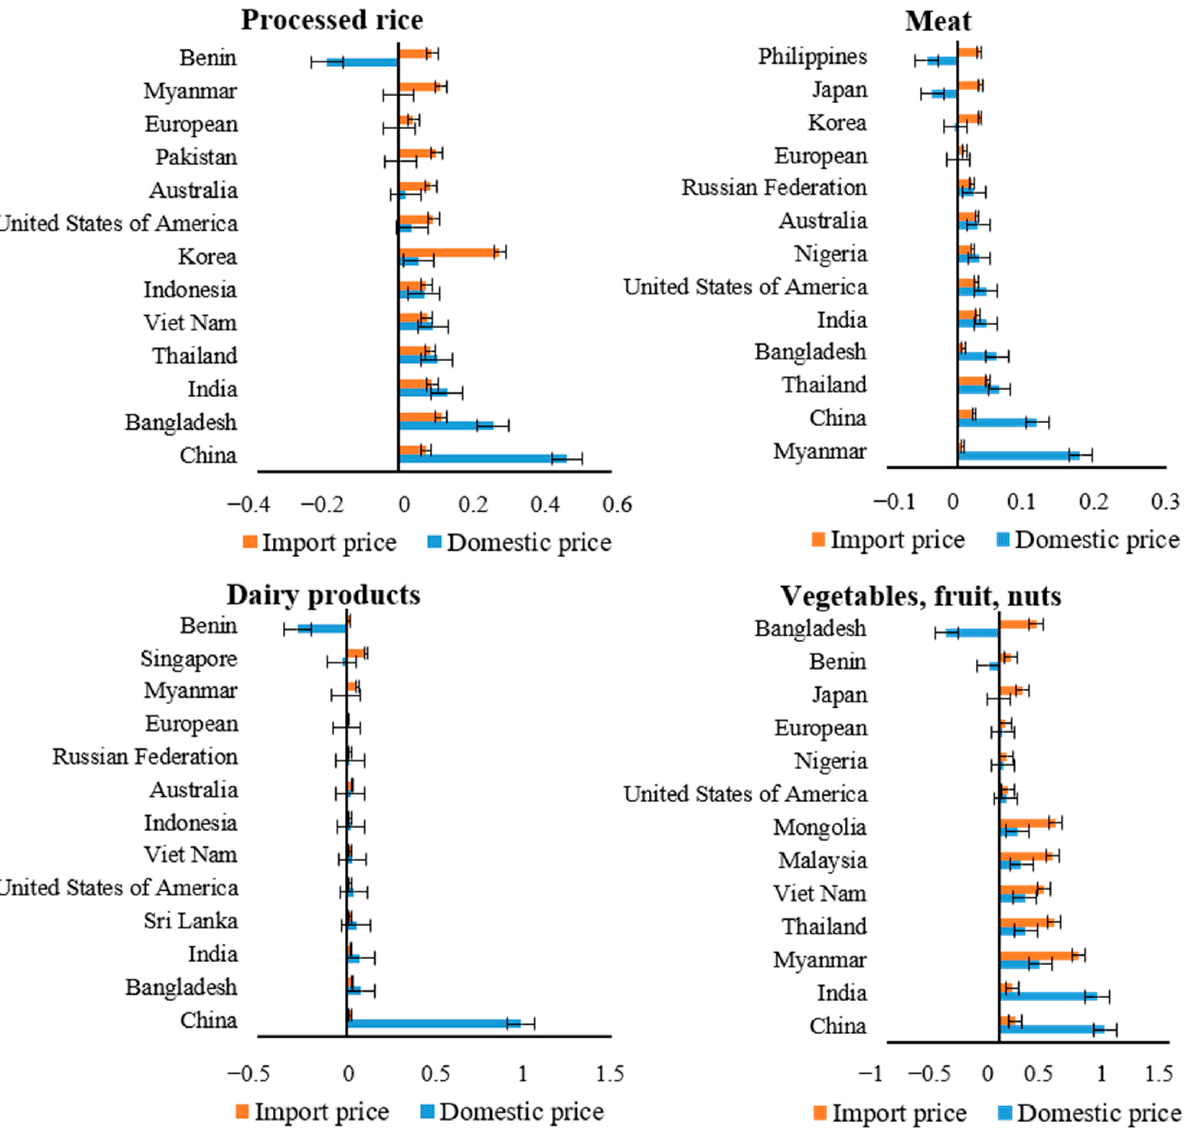
Figure 3. The most representative price fluctuations for four food categories in 2030. The globalization of food trade promotes deepening division, resulting in the concen- tration of major food production in advantageous regions. Global export patterns become centralized (Figure 2). Of the paddy rice exported in 2030, Asian and American countries account for 81.10% of the total. European countries are projected to have net wheat and corn export positions, comprising 60.58% and 41.73% of the global aggregate export volume. Similar to the distribution of livestock feed exports, animal-derived products (meat and dairy) are centered in America and Europe. China, Indonesia, and Europe account for 78.51% of exported fish. Other coastal Asian countries, namely Myanmar, Bangladesh, Vietnam, and the Philippines, present rates of increase in terms of fish exports that are above the global average (ranging from 1.26% to 3.13%). Increased exports in Africa mainly depend on fruits and vegetables (more than 1%, double the global average). Due to having little competitive advantage when it comes to food processing, African countries increase their export share of unprocessed materials, including raw milk and livestock. Benin, the main exporter in Africa, takes full advantage of competitive domestic prices and expands its exports of milk (2.89%), meat (2.65%), and fruits and vegetables